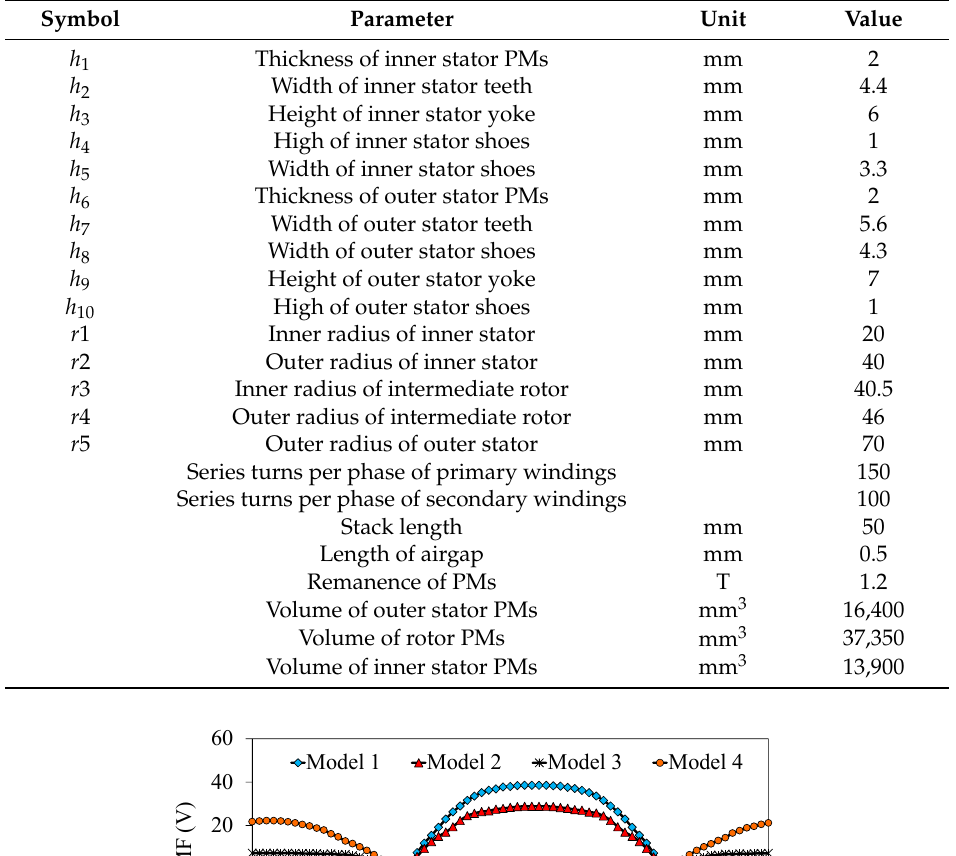
Table 3. Dimension parameters of TPMEV-DS Machine.